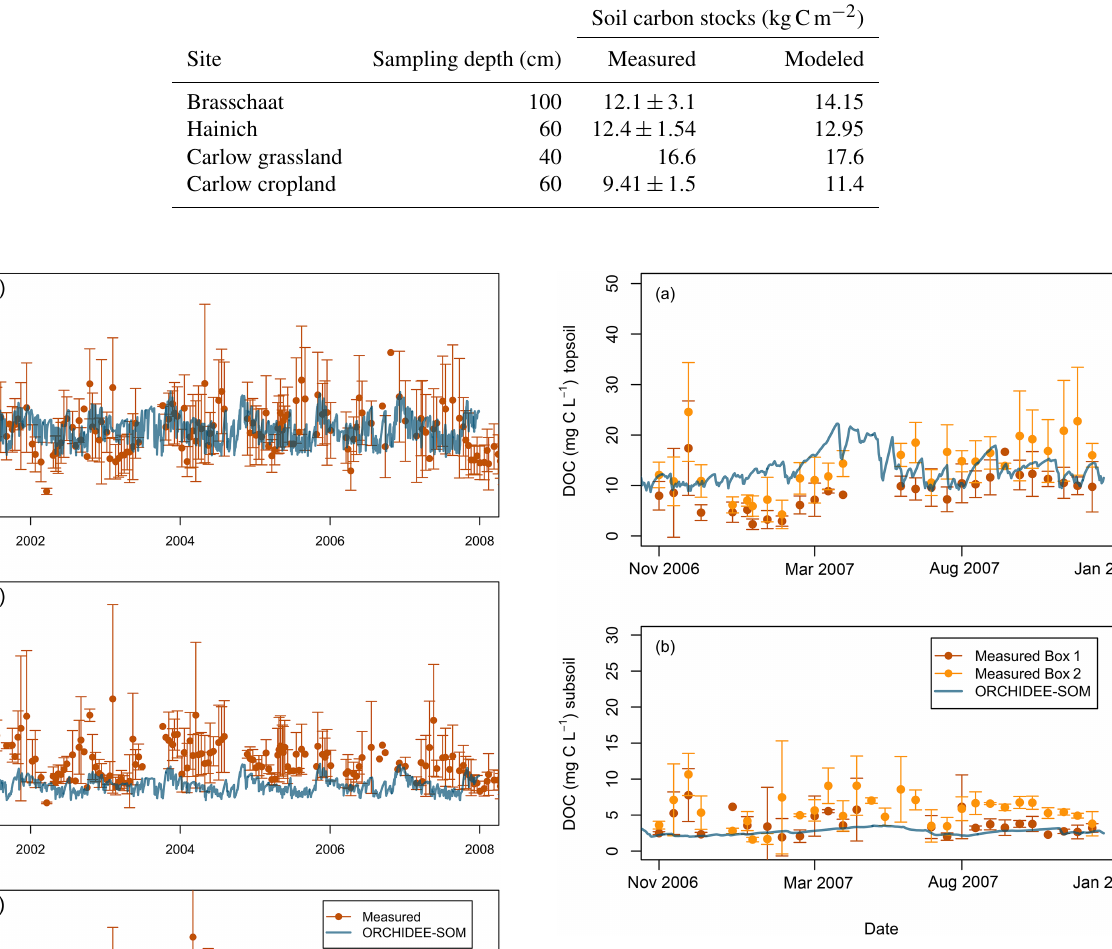
Figure 6. ORCHIDEE-SOM simulated (daily values) and measured DOC dynamics at Carlow grassland at two soil layers: (a) top- soil 10–30cm and (b) subsoil 60–75cm. Site measurements are in brown for Box 1 and in orange for Box 2, and simulation results using ORCHIDEE-SOM (daily values) are in blue. Error bars rep- resent the standard deviation of site measurements ( n =